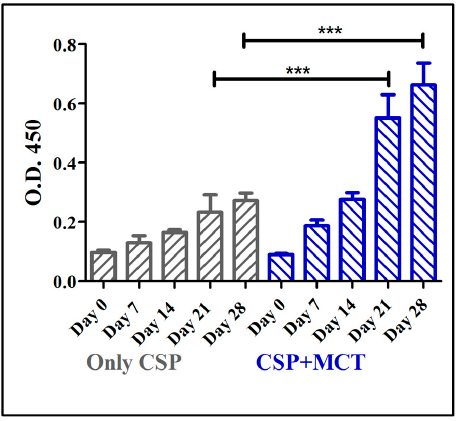
Figure 2. Mouse whole IgG ELISA against chimeric CSP 210-247. C57BL/6 mice were immunized with 5 μ g CSP + 2% MCT or only CSP two times, prime (day 0) and boost (day 14); and blood was taken weekly from day 0 (before the prime) until day 28, two weeks after the boost. Antibodies production (whole IgG) increased from day 7 to day 28 in both group. Titers were statistically significantly different between the groups on days 21 and 28.